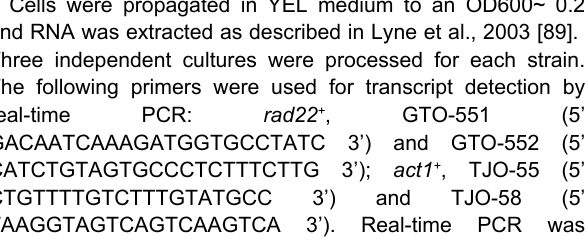
Figure S3. Supplemental data to Figure 4. (A) Fluorescence imaging of Rad22-YFP in wild type and ufd1ΔCt 213-342 mutant before and after treatment with Zeocin (300 µg/ml for 1 hr.) (B) rad22 transcript levels are similar in wild-type and ufd1ΔCt 213-342 mutant cells. Real-time RT-PCR analysis of rad22 RNA isolated from wild-type or ufd1ΔCt 213-342 cells. rad22 RNA quantities were measured relative to actin. Error bars indicate the standard deviation obtained from three independent biological